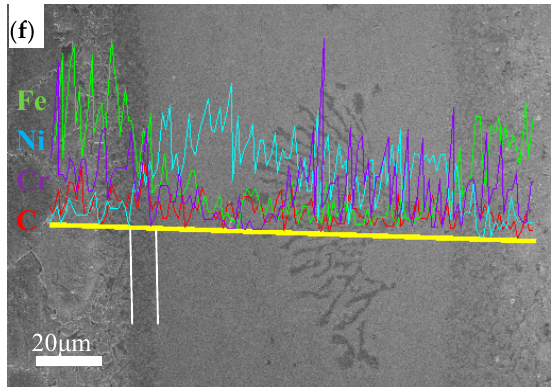
Figure 3. Microstructure of vacuum brazing joint of 1Cr18Ni9Ti with BNi82CrSiBFe filler metal: